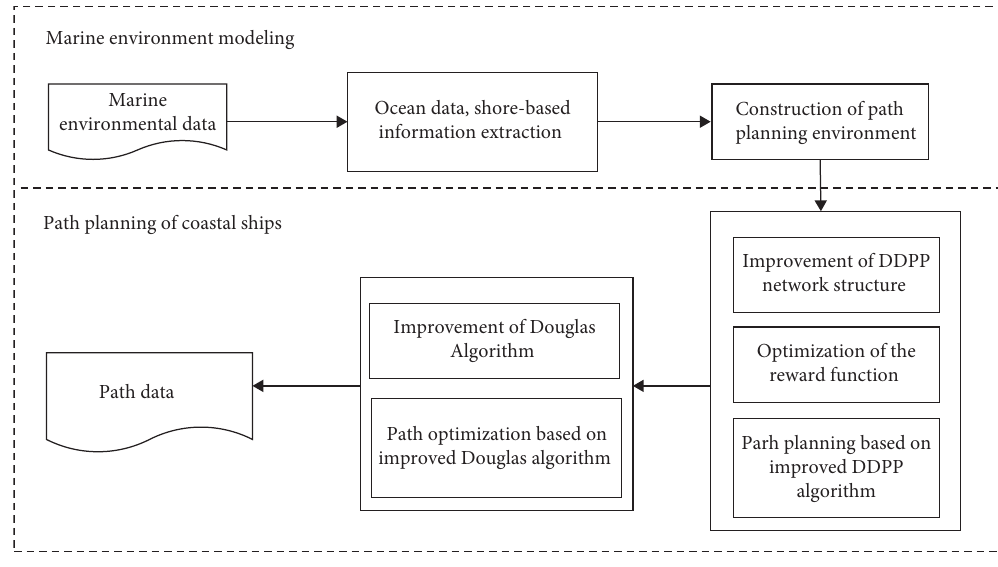
Figure 1: Coastal ship path planning framework.